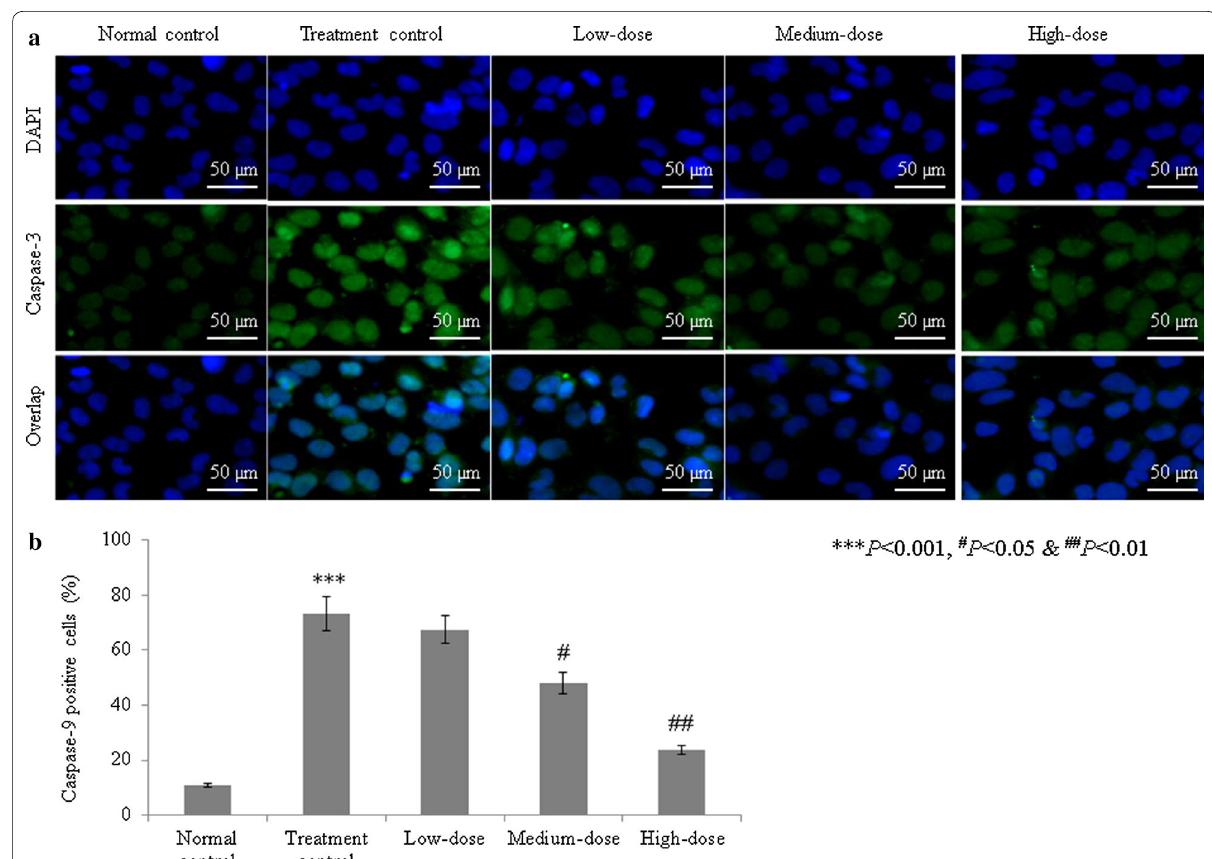
Fig. 6 Effect of catalpol on caspase-9 expression in human induced pluripotent stem cells with aconitine-induced cardiac arrhythmia. Catalpol treatment decreased the percentage of caspase-9-positive cells by 7.9, 34.3, and 67.8% at concentrations of 1, 10, and 100 µM, respectively. a Immunofluorescent images of caspase-9-positive cells. b Percentage analysis of caspase-9-positive cells. *** P < 0.001 vs. Group I; # P < 0.05 and ### P < 0.001 vs. Group II. Scale bar is 50